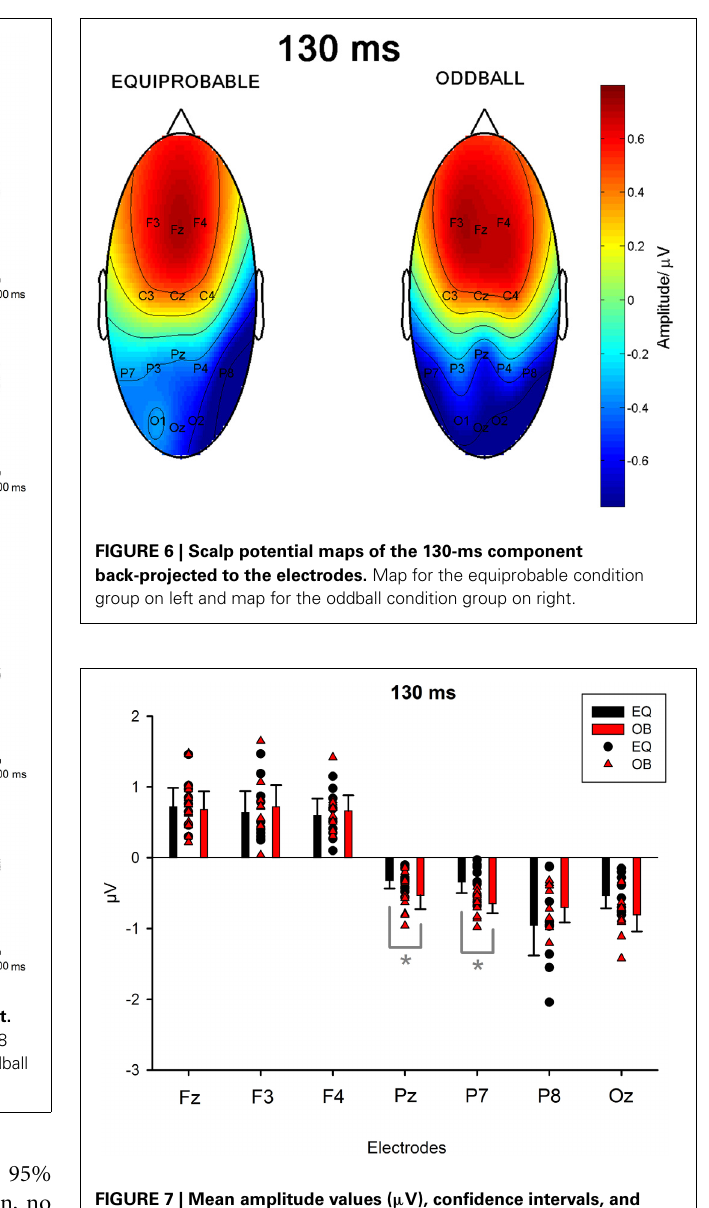
FIGURE 7 | Mean amplitude values ( µ V), confidence intervals, and scatterplots of the individual participants’ values for each electrode in the equiprobable condition (EQ) and oddball condition (OB) for the 130-ms component (differential response; emotional minus neutral face). An asterisk ( ∗ ) indicates a significant difference ( p < 0 . 05) between conditions at P7 and Pz electrodes.